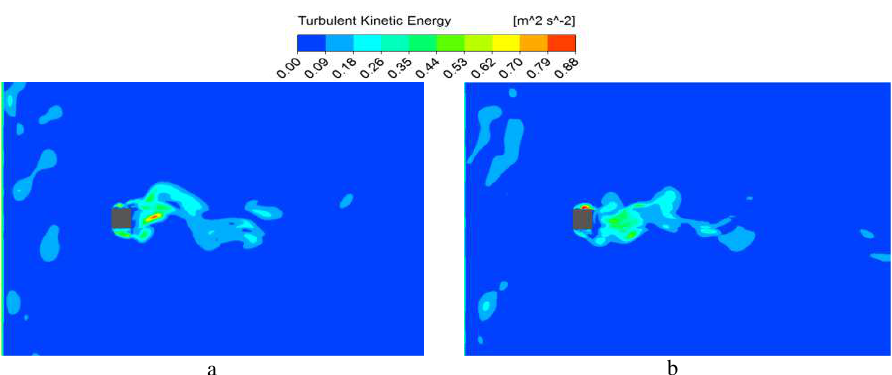
Fig. 3. The fields of the turbulence kinetic energy (k) on the plane Y1 at different instants of time (t): а ) 5.2 s, б ) 6.2s.